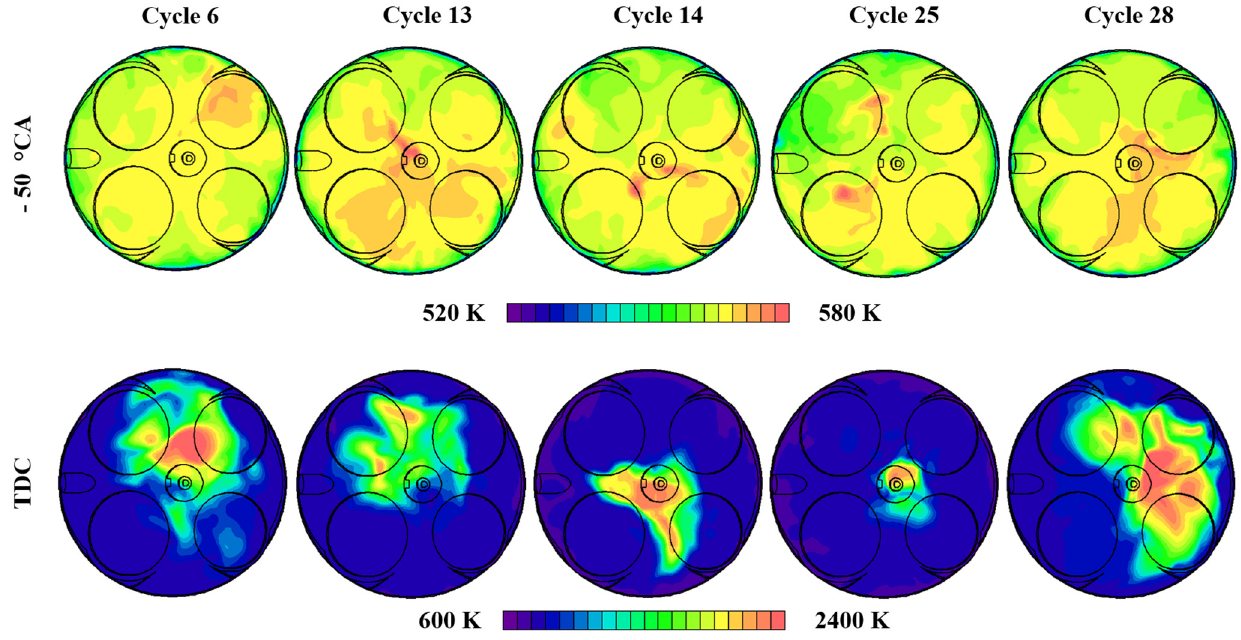
Figure 14. Temperature distributions at − 50 °CA and TDC.